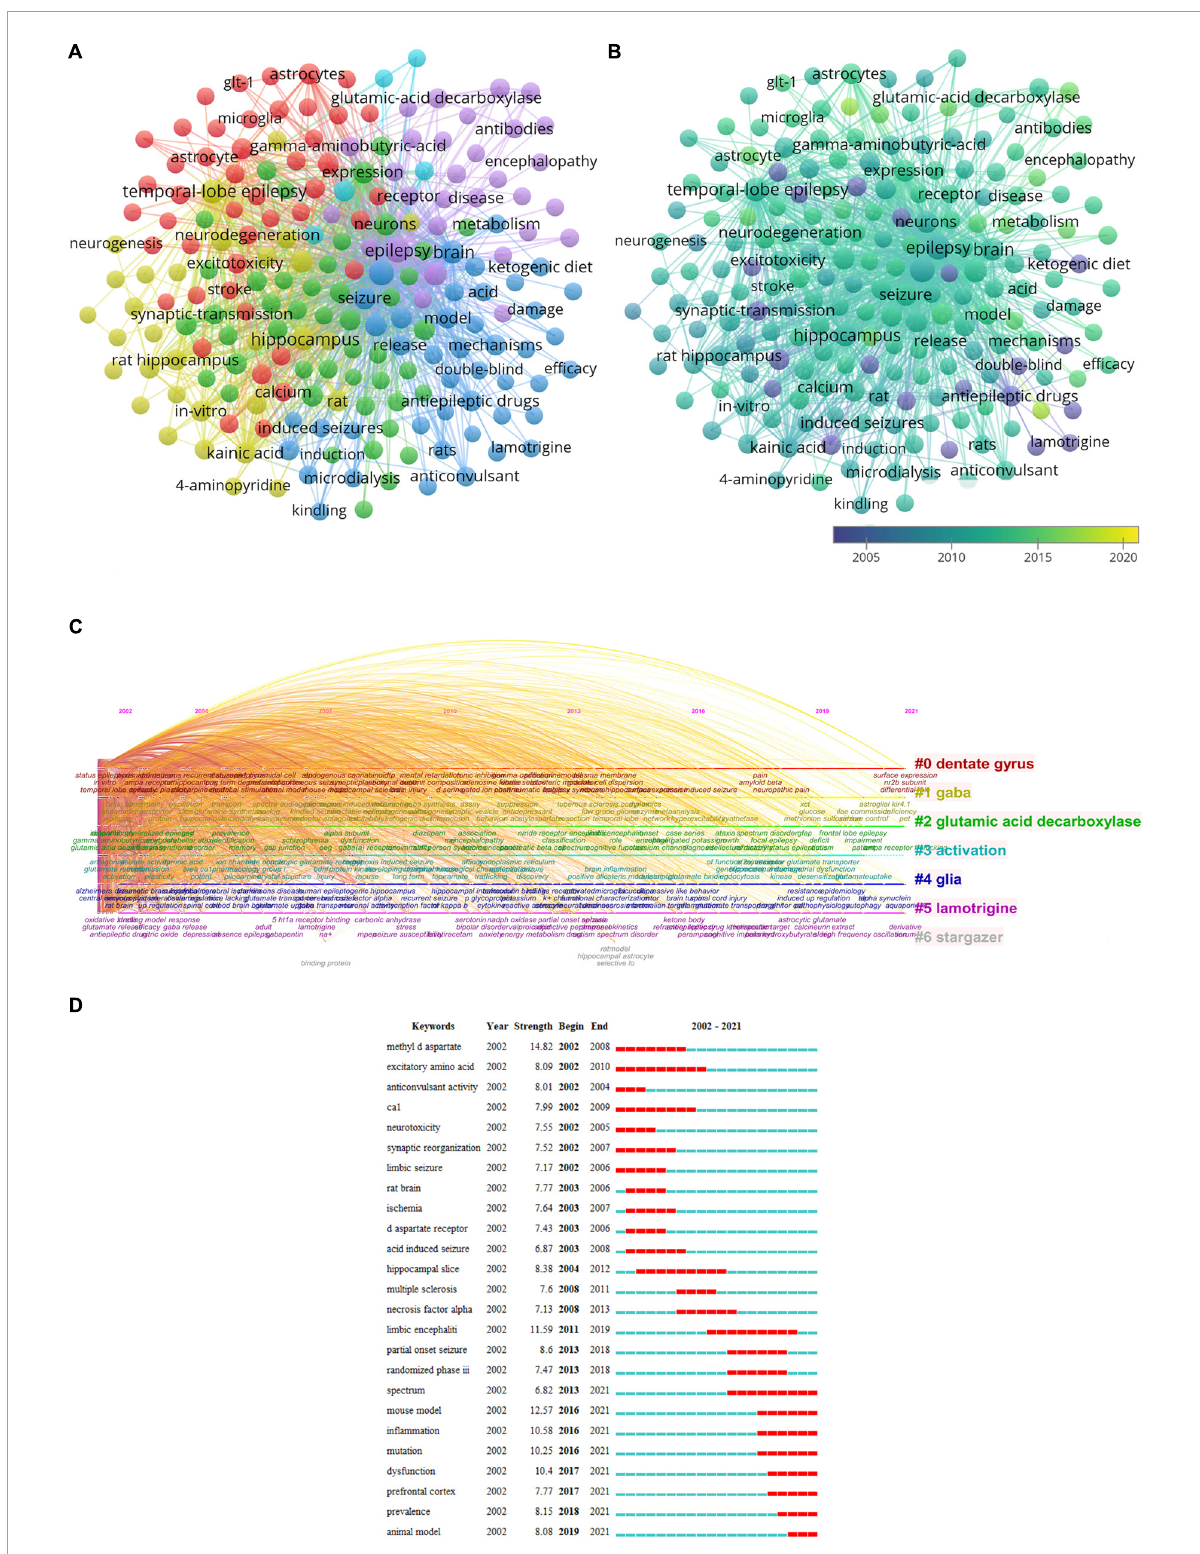
FIGURE8 Visualization analysis of keyword. (A) Network map of keywords. (B) Keyword visualization based on APY. (C) Cluster analysis of keywords based on timeline distribution. (D) Top 25 representative keywords with the strongest burstness.